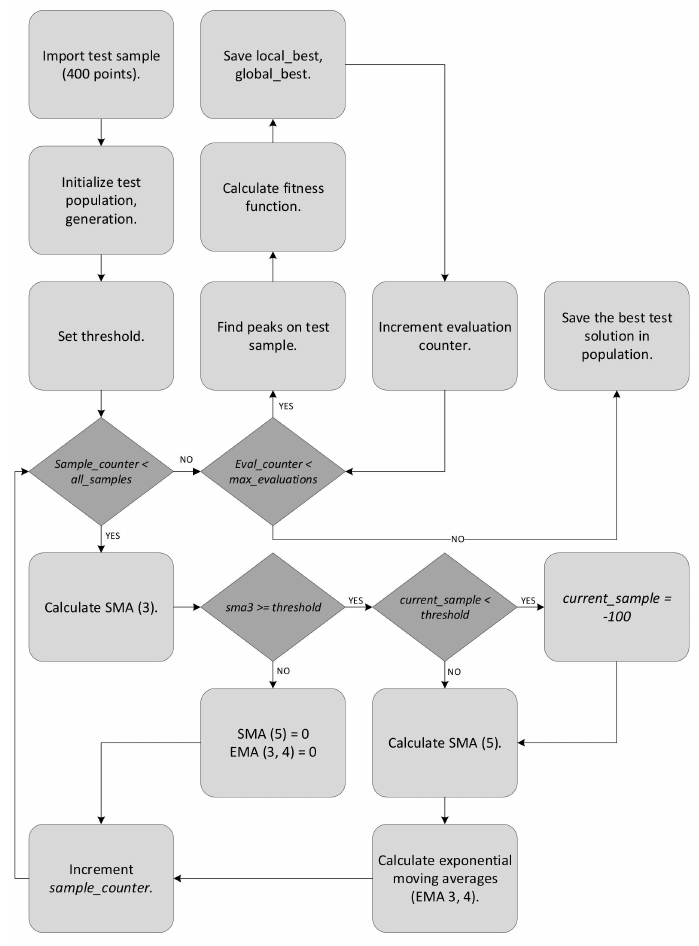
Figure 6. The PSO optimization process in